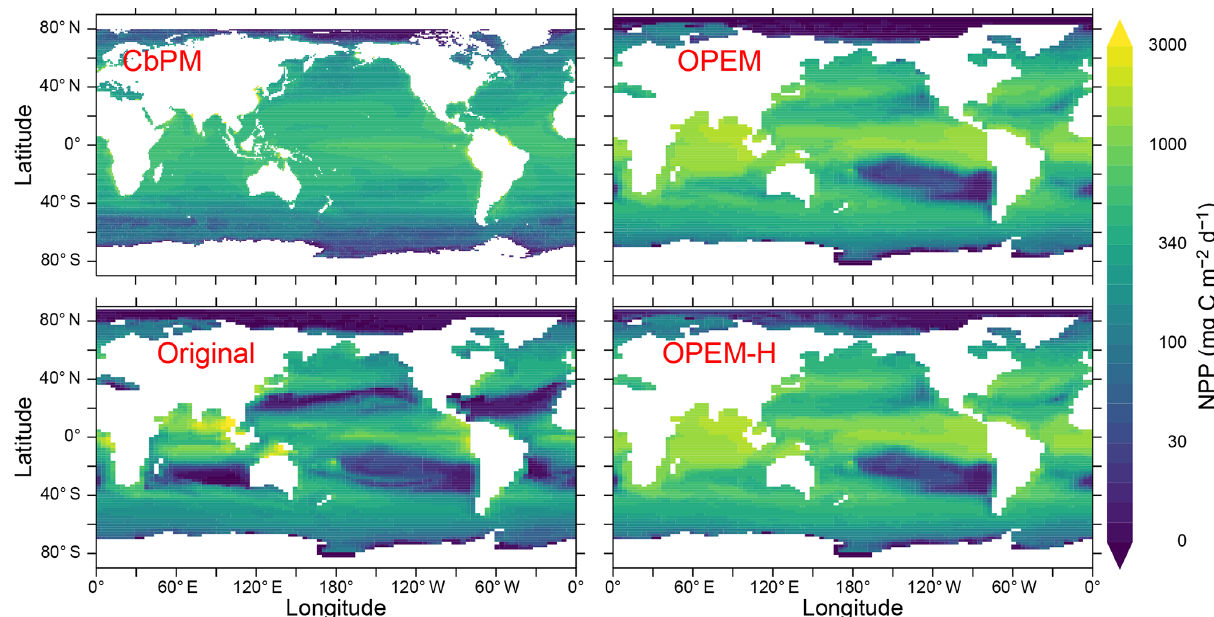
Figure 10. Annually averaged distribution of vertically integrated NPP estimated from satellite data via the CbPM and predicted from the original, OPEM, and OPEM-H UVic simulations. The satellite-based CbPM estimate is the average for 2012–2018 (Westberry et al., 2008) with missing data treated as